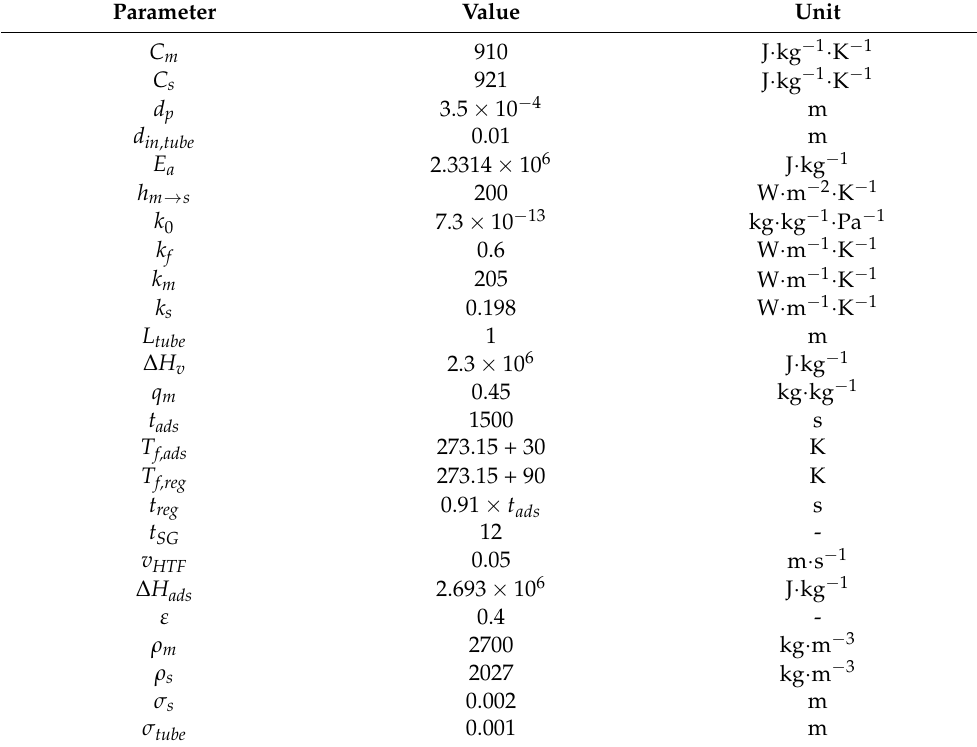
Table 2. Reference parameters used in the